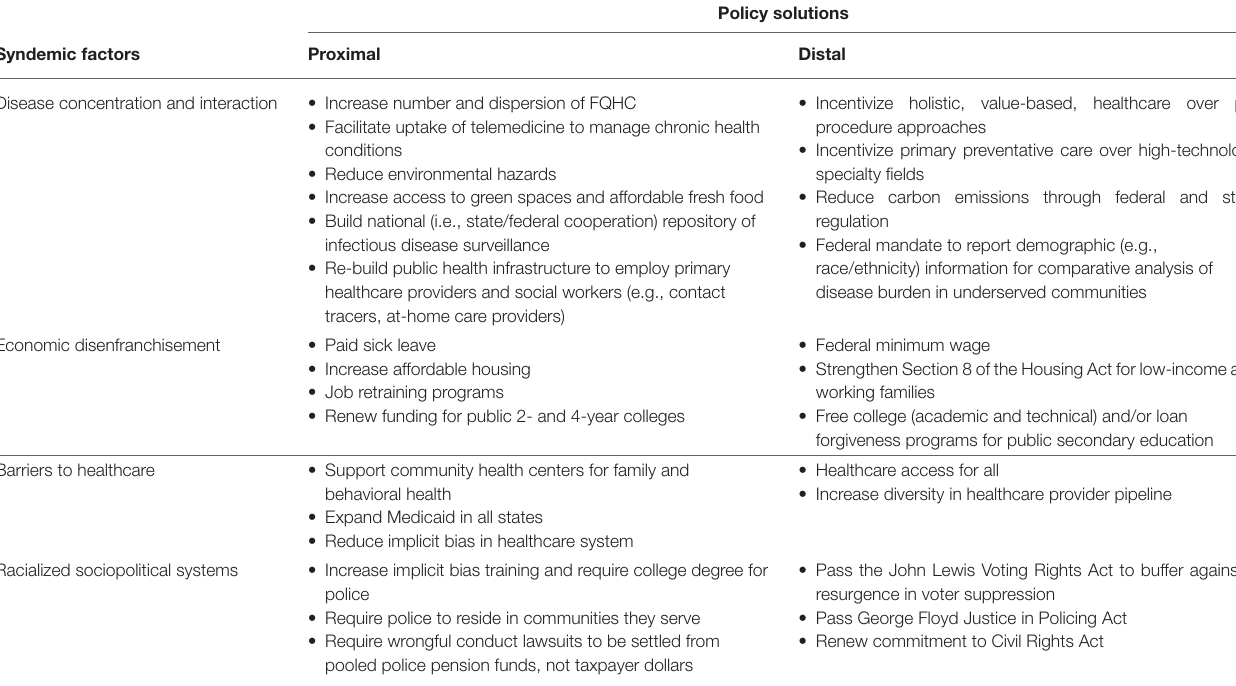
TABLE 1 | Syndemic factors with proximal and distal